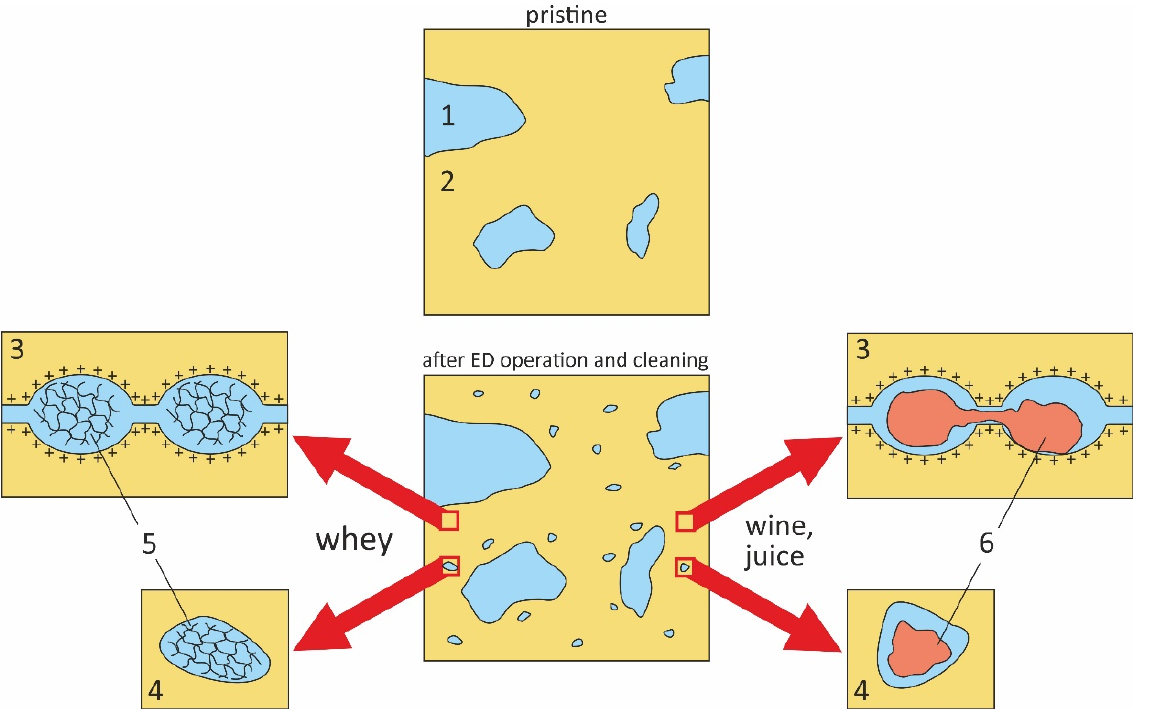
Figure 2. The proposed structure of AEMs that contain PVC as an inert filler, before and after their use in the ED process of wine tartrate stabilization: (1) macro-defects, filled with an external solution; (2) nanoporous medium; (3) nanopore with fixed groups on the walls, filled with an external solution; (4) nanopore with non-electrically charged walls filled with an external solution; (5) reticulated hydraulically permeable colloidal structures; (6) hydraulically impermeable colloidal aggregates. Adapted from [58,59].